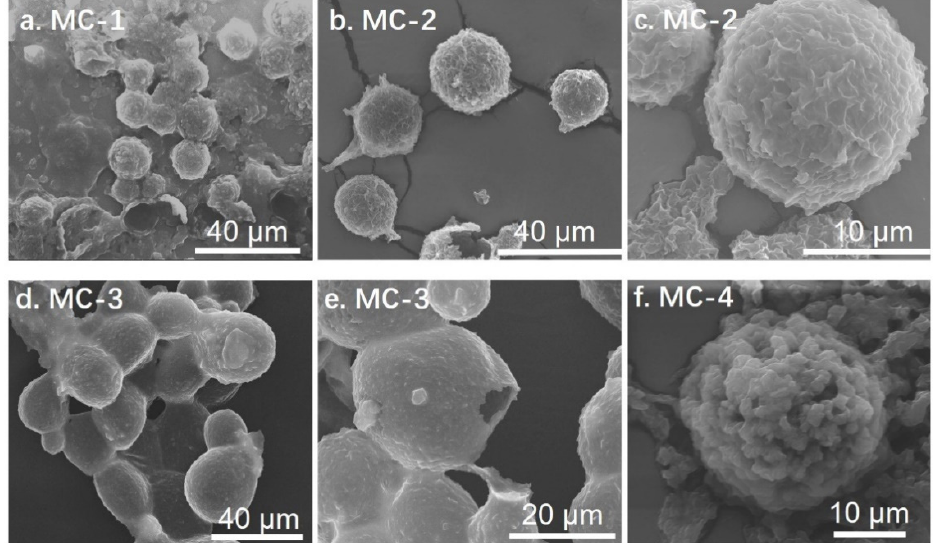
Figure 1. The morphology of the GO microcapsules from ( a – f ) MC-1 to MC-4 with an increasing content of BTA.